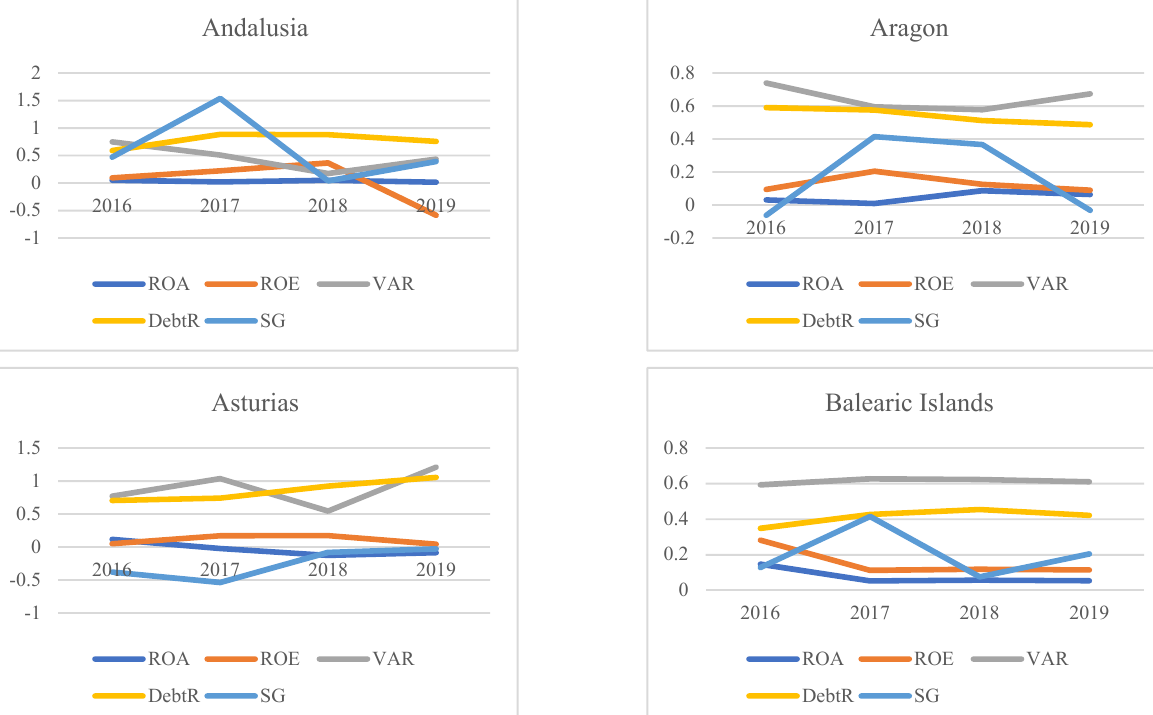
Figure 1. Evolution of financial and economic performance by Portuguese NUTs II regions, 2016–2019. ROA: return on assets; ROE: return on equity; VAR: value-added ratio; DebtR: debt ratio; SG: sales growth.